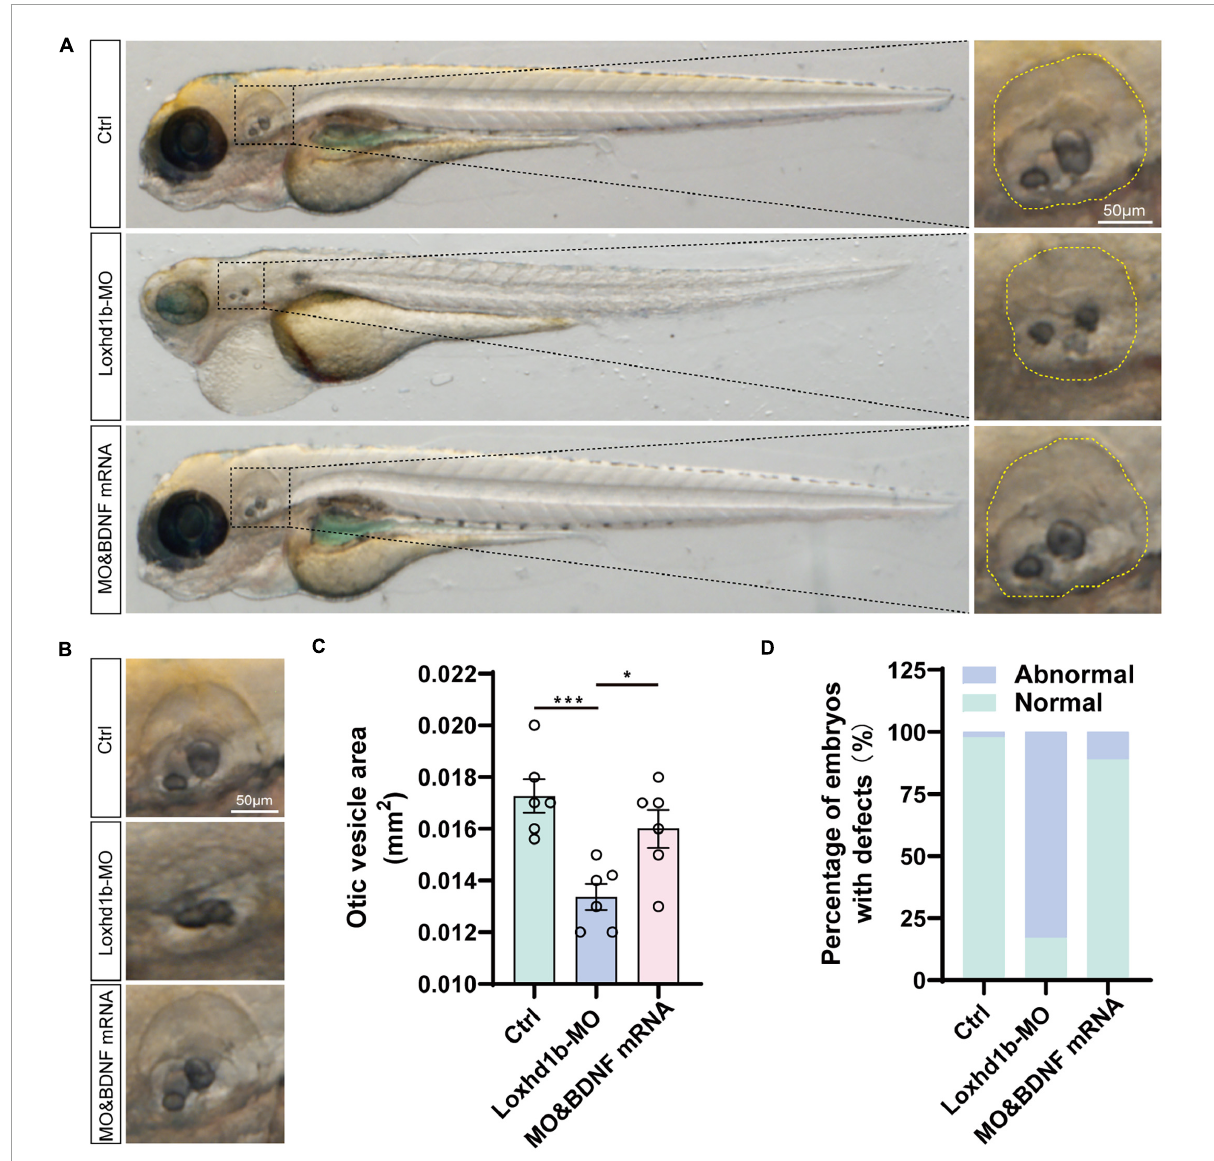
FIGURE9 Loss of function of Loxhd1b causing the defects of otic vesicle and otoliths. (A) Imaging analysis of otic vesicle and cristae hair cells in control, Loxhd1b morphants, and rescue group at 96 hpf. The yellow dotted line marks the boundary of the otic vesicle. Scale bar = 50 µ m. (B) BDNF mRNA is effective to rescue the reduced number of otoliths and smaller size of otic vesicle caused by Loxhd1b MO. Scale bar = 50 µ m. (C) Statistical analysis of otic vesicle area in different groups at 96 hpf. (D) Proportions of embryos with developmental defects at 72 dpf. * P < 0.05 and *** P <